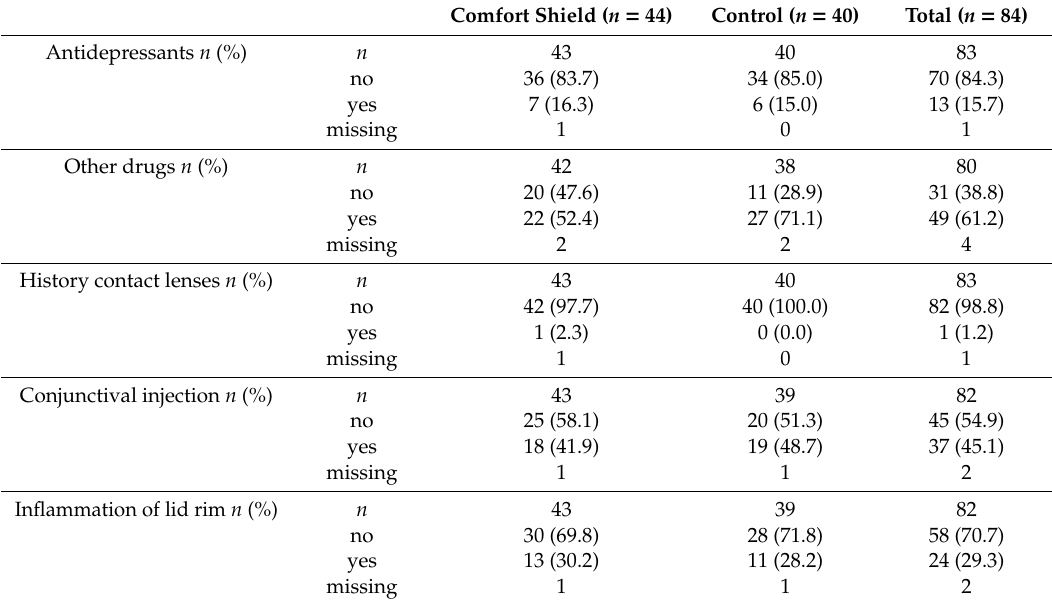
Table A1. Tabular overview of the medical history according to the treatment arm—PPS population ( n = 84).